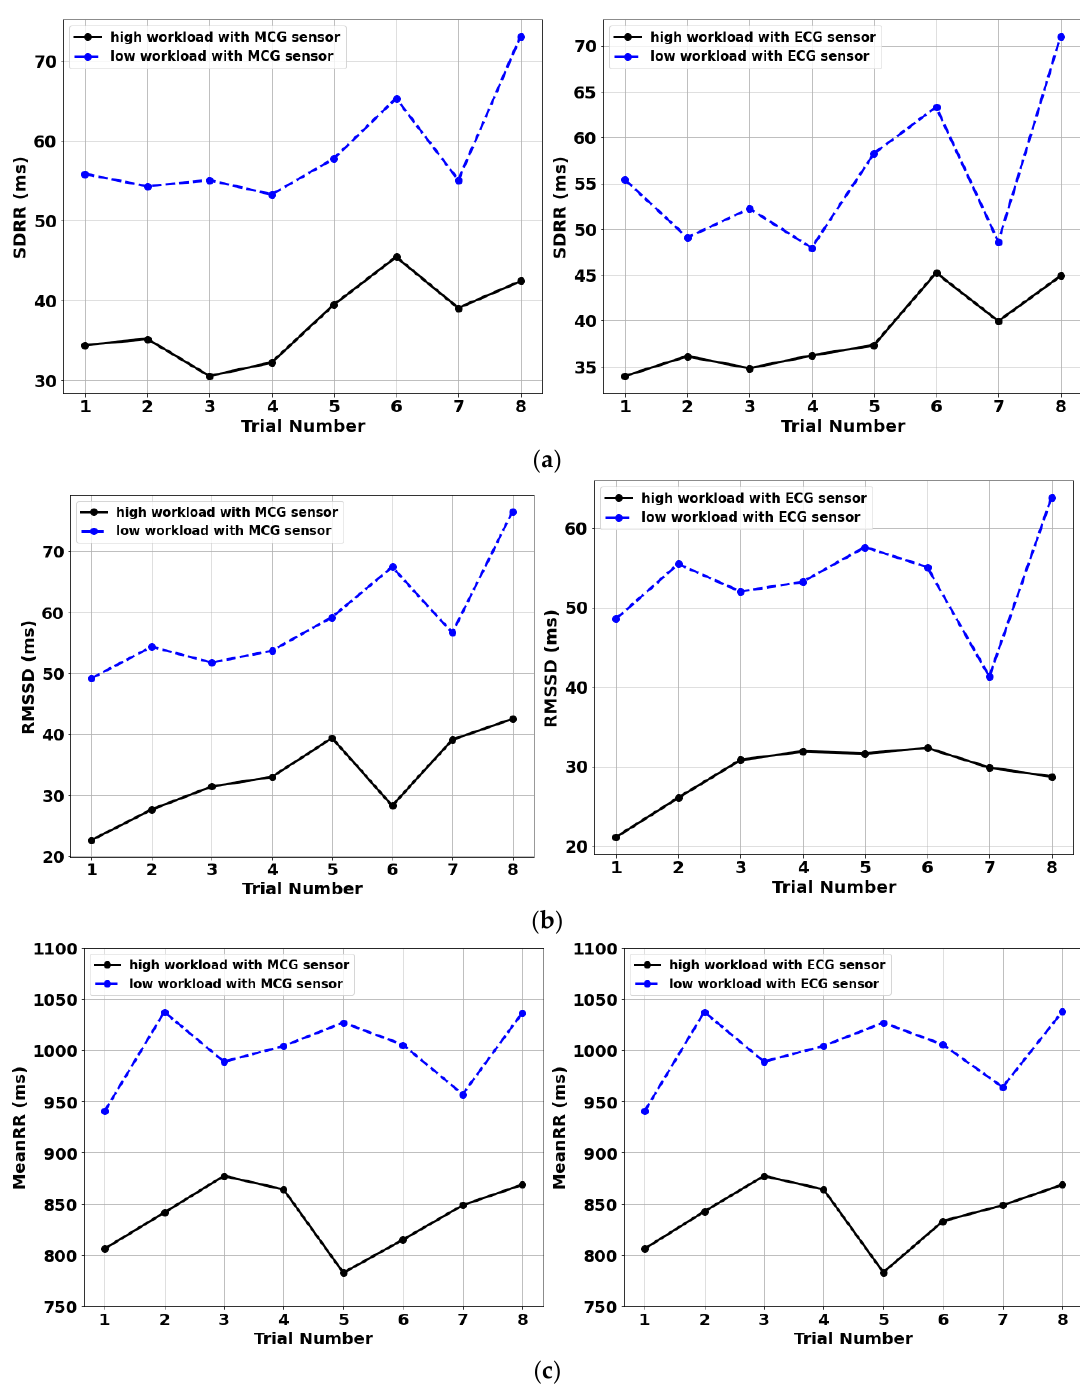
Figure 4. Comparison of HRV parameters for a single participant repeating 8 sessions of low (blue- dashed) and high (black-solid) cognitive workload conditions: ( a ) SDRR, ( b ) RMSSD and ( c ) MeanRR.